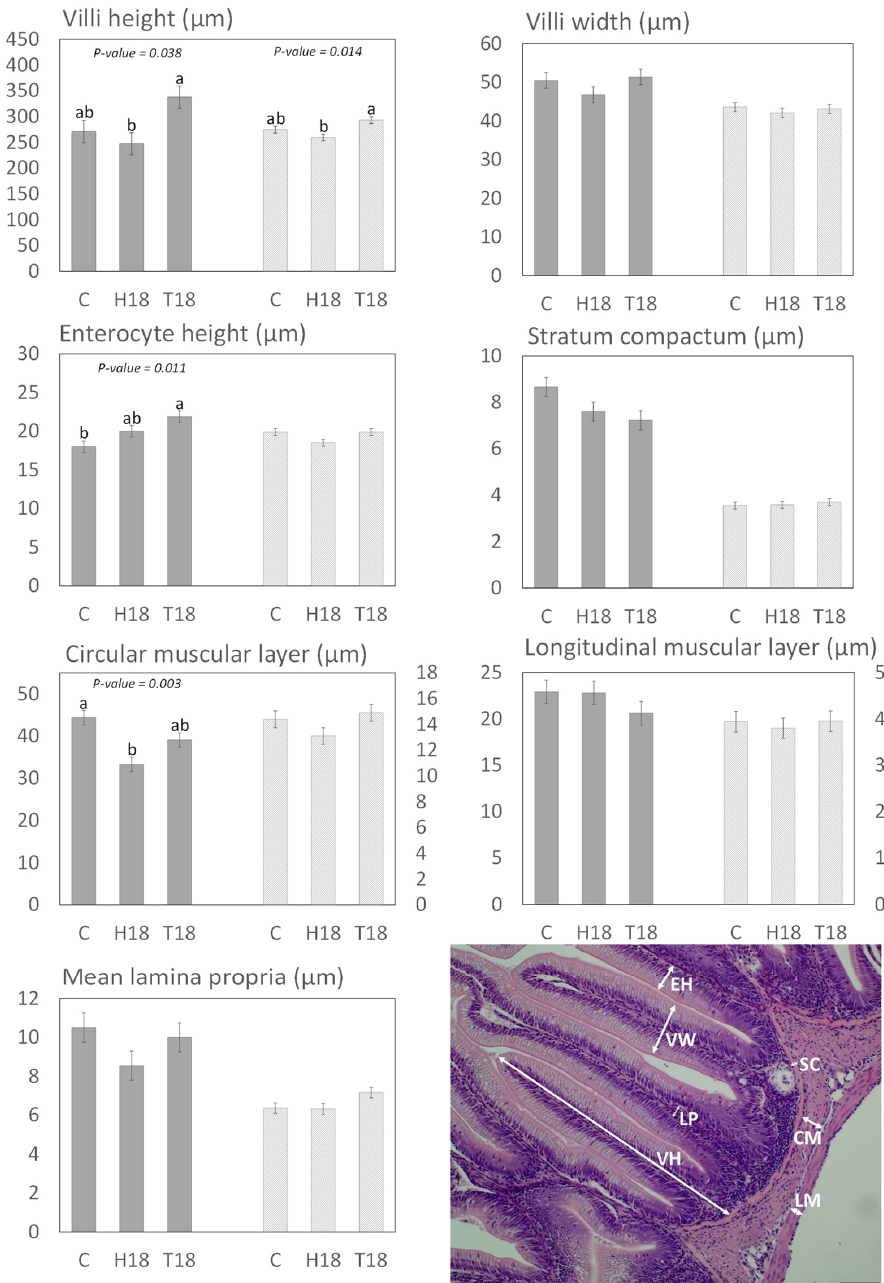
Figure 1. Histomorphology of rainbow trout gut. C: control diet; H18: 18 % HI inclusion; T18: 18 % TM inclusion. Grey bars: distal intestine measures; striped bars: pyloric caeca measures. a, b Show statistically significant differences among diets ( p < 0.05); Values expressed as mean ± standard error of the mean (SEM; n = 4 tanks per diet, 2 fish per tank). Microphotograph representative of measures for gut: villi height (VH), villi width (VW), enterocyte height (EH), stratum compactum (SC), circular muscular layer width (CM), longitudinal muscular layer width (LM), lamina propria width (LP). Scale bar = 100 μ m.